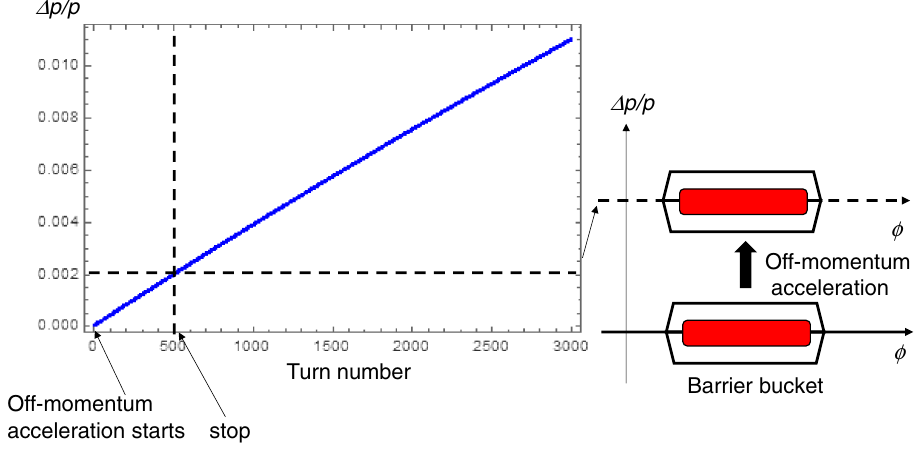
FIG. 4. Evolution of momentum deviation associated with off-momentum deceleration.